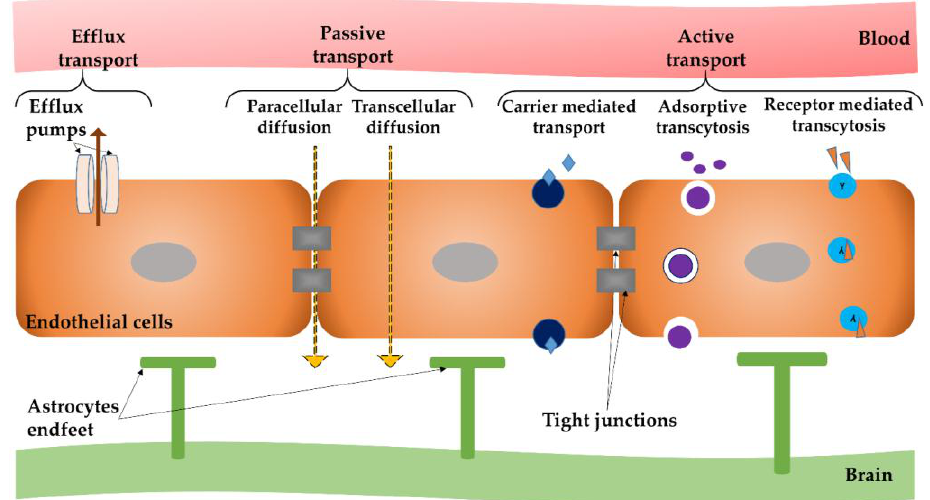
Figure 1. Different modes of transport across the blood–brain barrier (BBB).